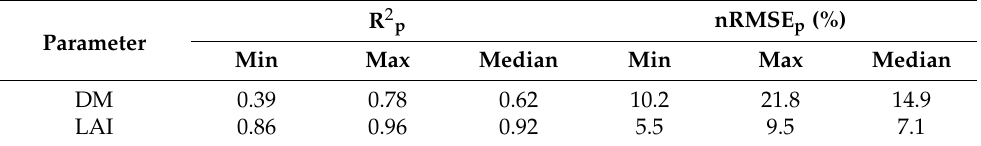
Table 3. Model performance for DM and LAI prediction. Minimum, maximum and median values of 100 model runs with different randomly selected calibration (80%) and validation (20%) samples. R 2 p nRMSE p Parameter